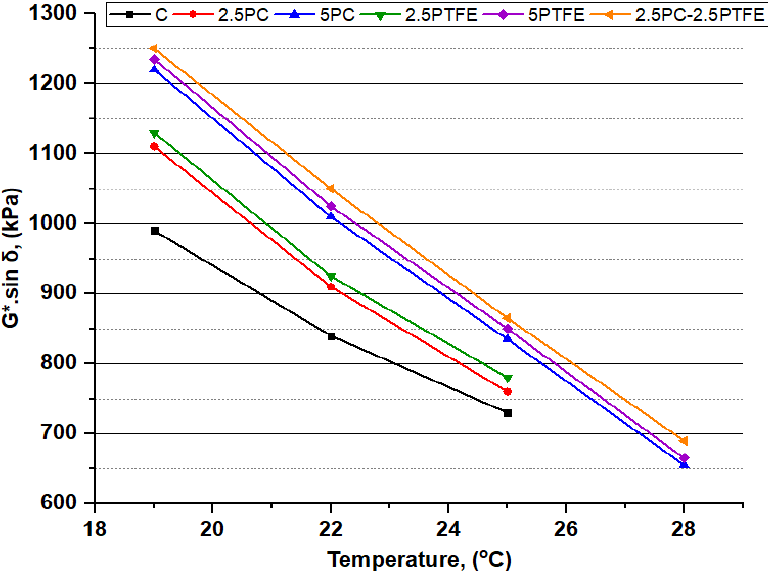
Figure 10. G*.sin δ and temperature relationship of all the PAV-aged binders.